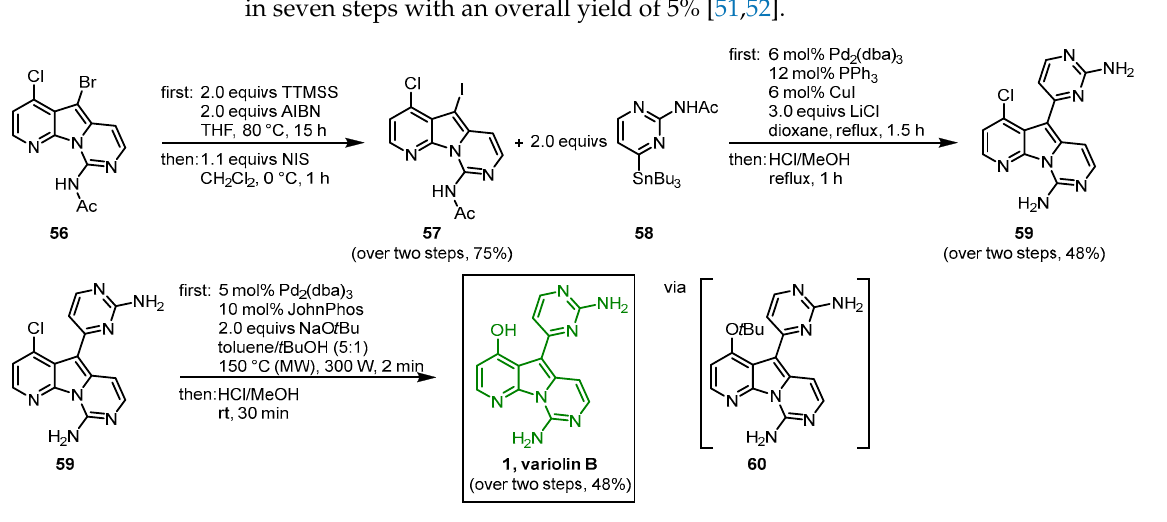
Figure 12. Palladium-mediated synthesis of variolin B ( 1 ) [51].